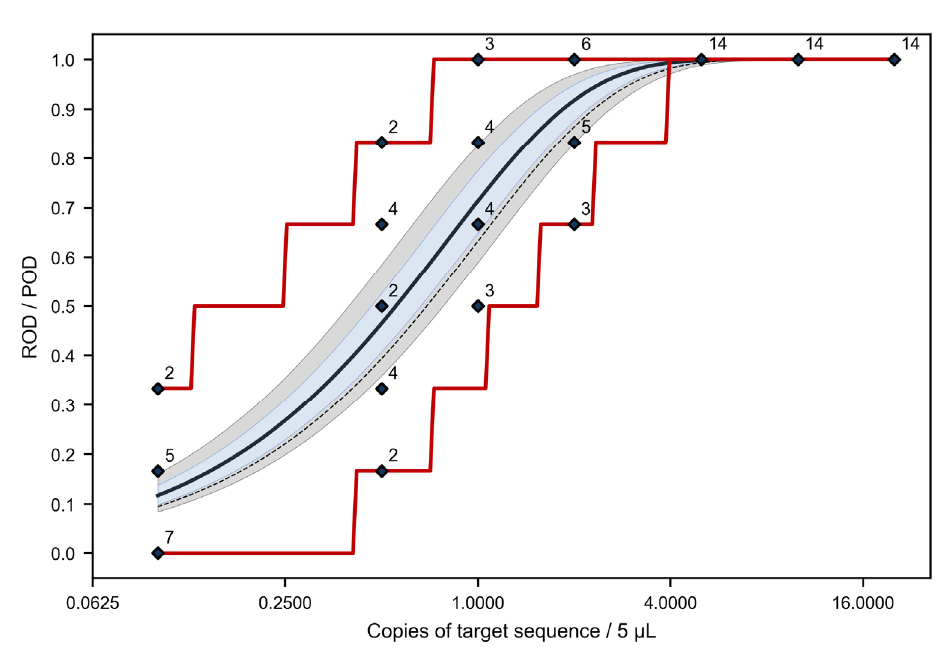
Figure 2. POD curve across laboratories (dark blue) with associated 95% confidence range (light blue) and 95% prediction range (light gray), laboratory-specific rate of detection (ROD) (blue diamonds, numerical values give the numbers of laboratories with the respective ROD) with associated 90% prediction interval (red). The ideal POD curve obtained under optimal conditions is given as dashed line.